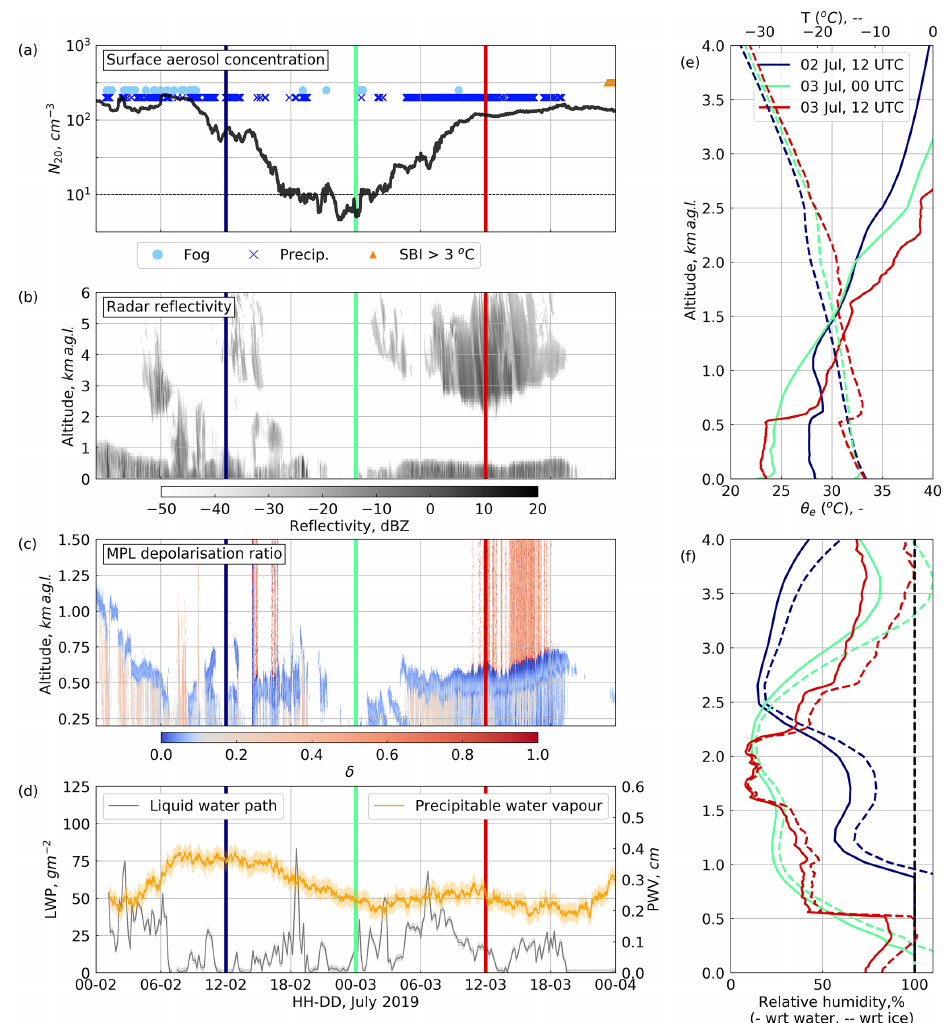
Figure 11. Conditions during the 3 July 2019 low-aerosol case study. (a) Surface N 20 (CPC), with occurrences of fog (OPC-N3), precipitation (POSS), and SBI > 3 ◦ C events indicated. (b) Radar reflectivity (MMCR). (c) Lidar depolarisation ratio (MPL); blue colours represent liquid droplets and reds are ice crystals. (d) Column integrated liquid water path and precipitable water vapour (MWR). (e) Temperature (dashed) and equivalent potential temperature (solid) radiosonde profiles. (f) Relative humidity with respect to water (solid) and ice (dashed) from radiosonde profiles. The coloured vertical lines on the left-hand plots correspond to the time of each vertical radiosonde profile in the right-hand